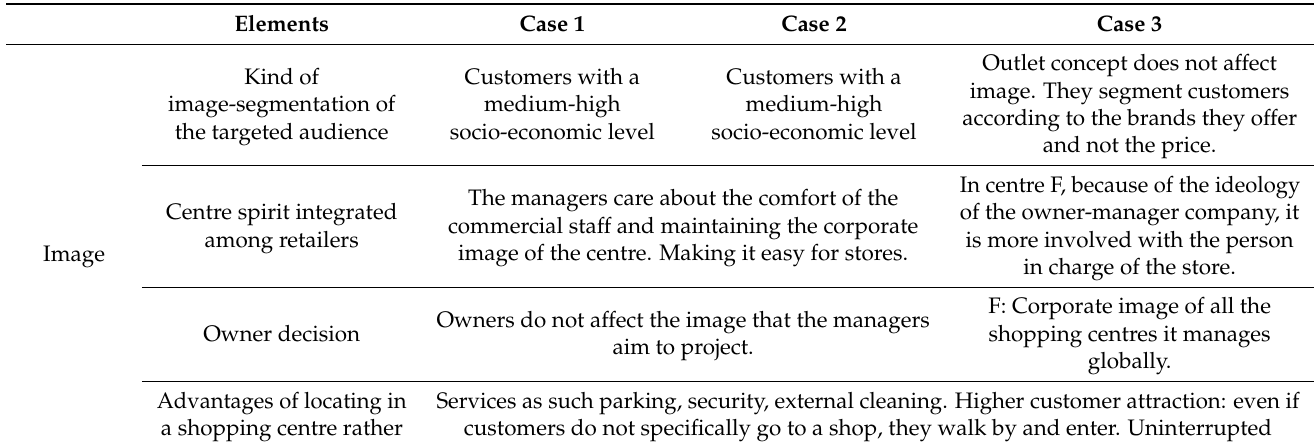
Table 7. The image of the centre to be projected and how it works 1 .